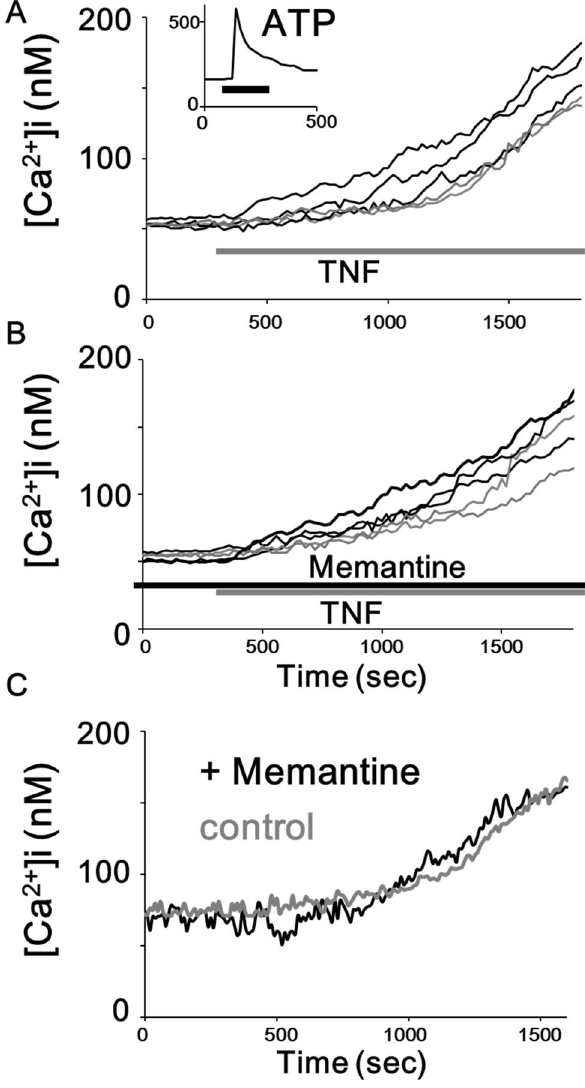
Figure 2. Pretreatment with memantine did not affect the elevation of [Ca 2+ ]i induced by TNF in rodent microglial cells. ( A ) Five representative traces showing a treatment of 3 ng/mL TNF-induced sustained increase in [Ca 2+ ]i in mouse primary microglial cells. ( A , inset) The inset shows a 100 μM ATP-induced transient increase in [Ca 2+ ]i in mouse primary microglial cells. The average trace of 10 [Ca 2+ ]i traces in response to ATP is shown. ( B ) Five representative traces showing pretreatment with memantine did not affect the elevation of [Ca 2+ ]i induced by TNF in mouse primary microglial cells. ( C ) Average traces of 5 [Ca 2+ ]i traces showing a treatment of 3 ng/mL TNF-induced sustained increase in [Ca 2+ ]i in mouse 6–3 microglial cells. Pretreatment with memantine did not affect the elevation of [Ca 2+ ]i induced by TNF in mouse 6–3 microglial